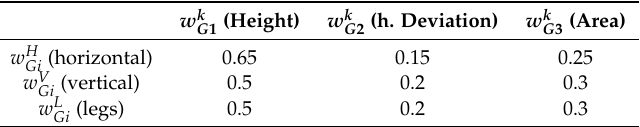
Table 1. Weights for similarity